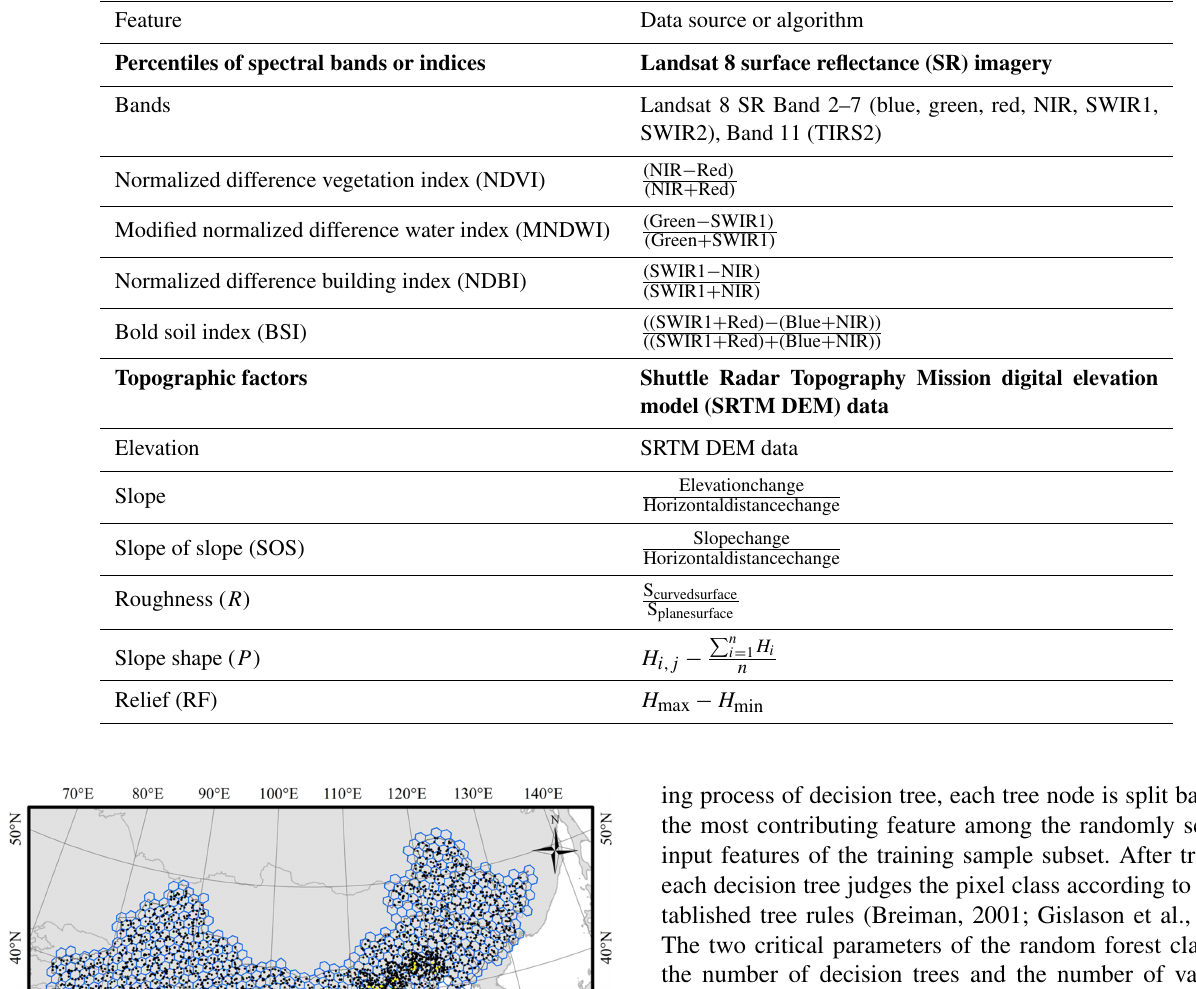
Table 2. Features for terrace/non-terrace classification. The type and data source of features are highlighted in bold.